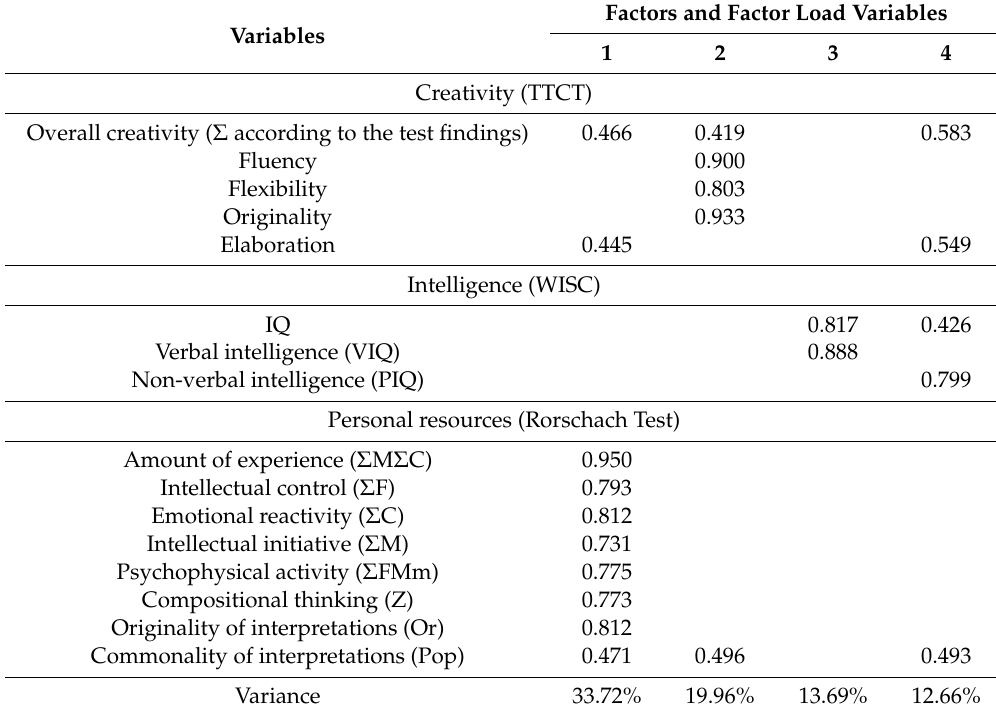
Table 3. Structure of children’s creativity, intelligence, and personal resources, Group